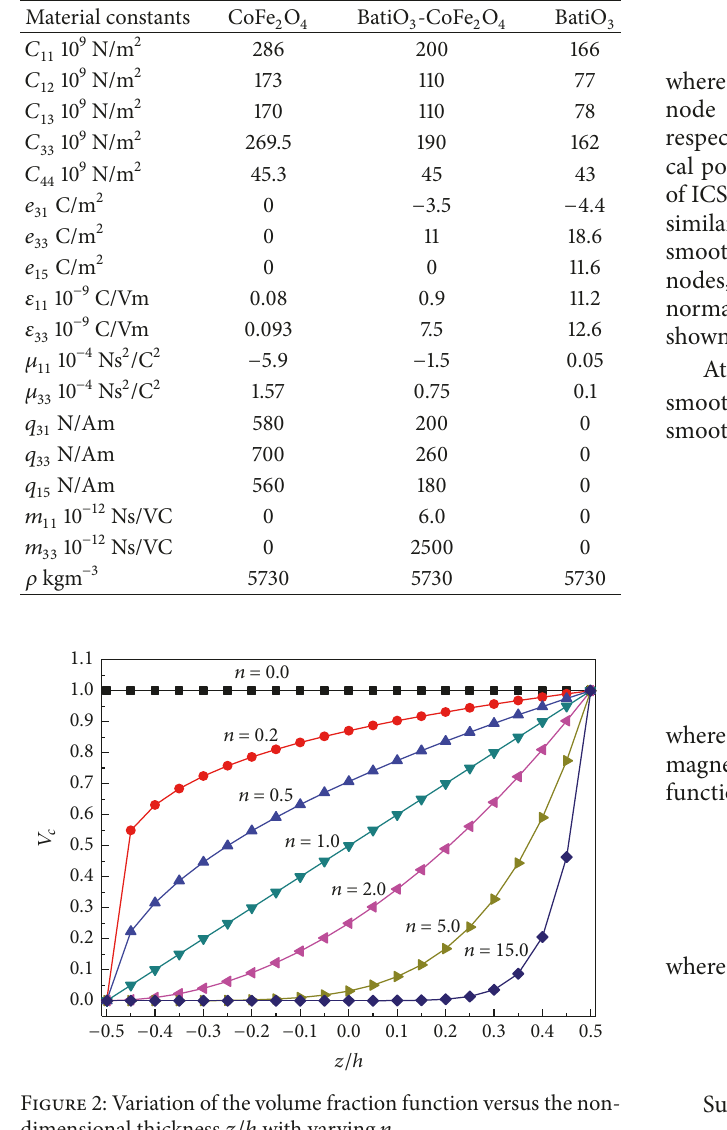
Table 1: Magnetoelectroelastic coefficients of material properties [6].